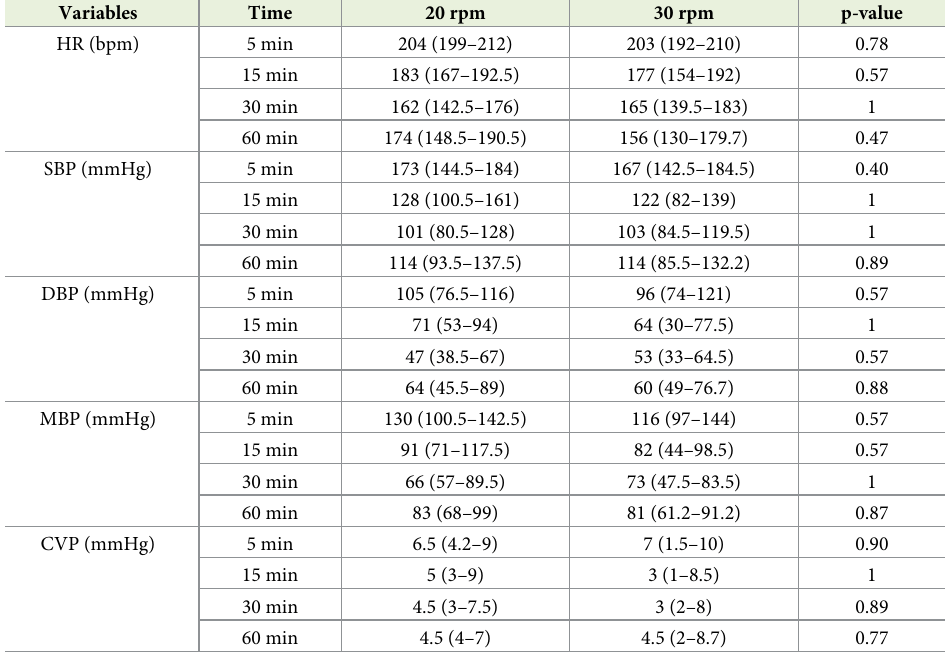
Data are expressed as medians